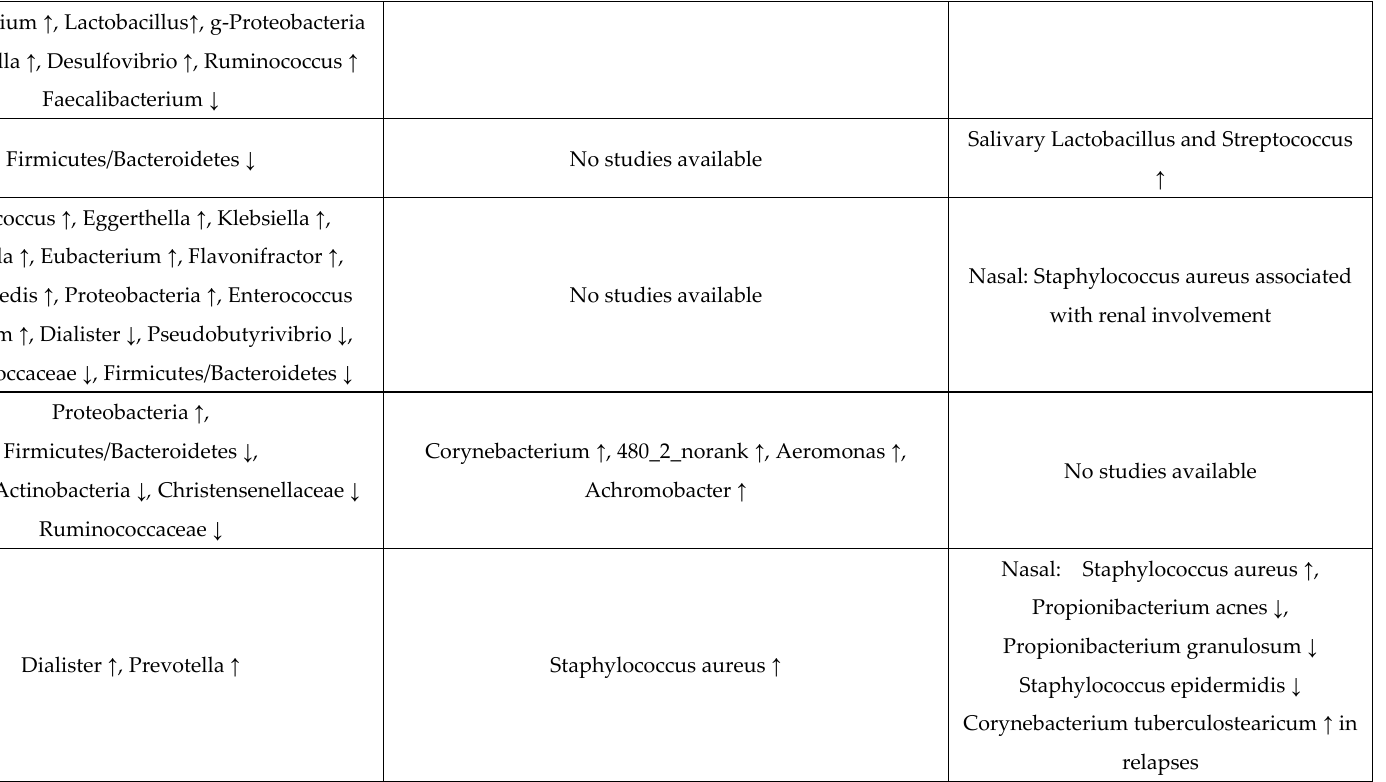
Figure 1. Microbiota changes in IPF, HP, CTD-ILDs and GPA. ↑ : increased compared to healthy individuals, ↓ : decreased compared to healthy individuals. Curved arrows depict the interactions between gastrointestinal tact and lung microbiota (gut-lung axis) and between lung and upper airways. For details see text.